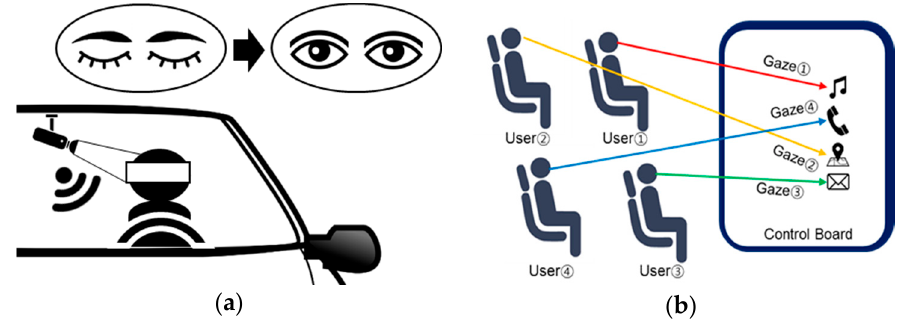
Figure 1. Various examples in a vehicle application: ( a ) a drowsiness warning system; and ( b ) an interface control system using multi-user eye tracking.